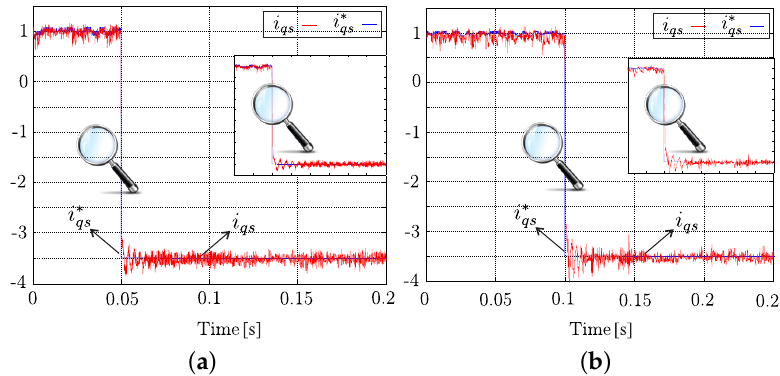
Figure 9. Experimental transient test in q -axis of stator currents from a speed change of 500 rpm to − 500 rpm at 8 kHz of sampling frequency considering: ( a ) λ xy = 0.05; ( b ) λ xy = 0.1.